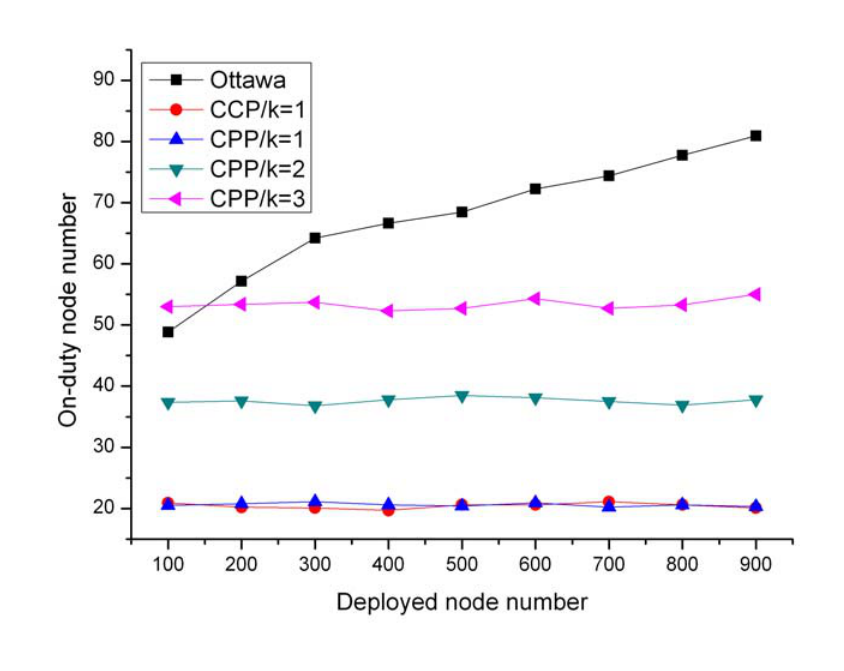
Figure 8. On-duty nodes used by